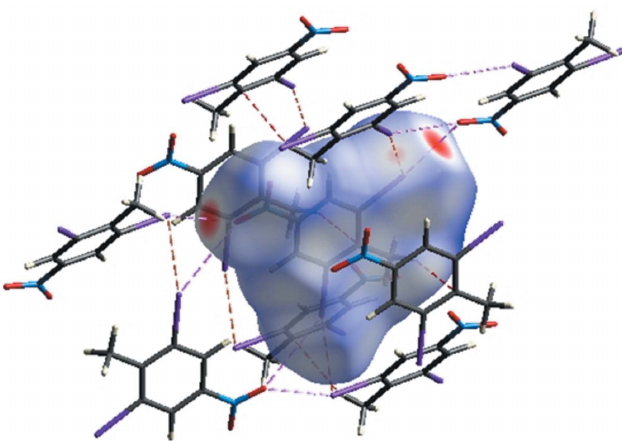
Figure 10 Hirshfeld surface for DCNT mapped over ( a ) calculated electrostatic potential, ( b ) d norm , ( c ) shape-index and ( d ) curvedness.